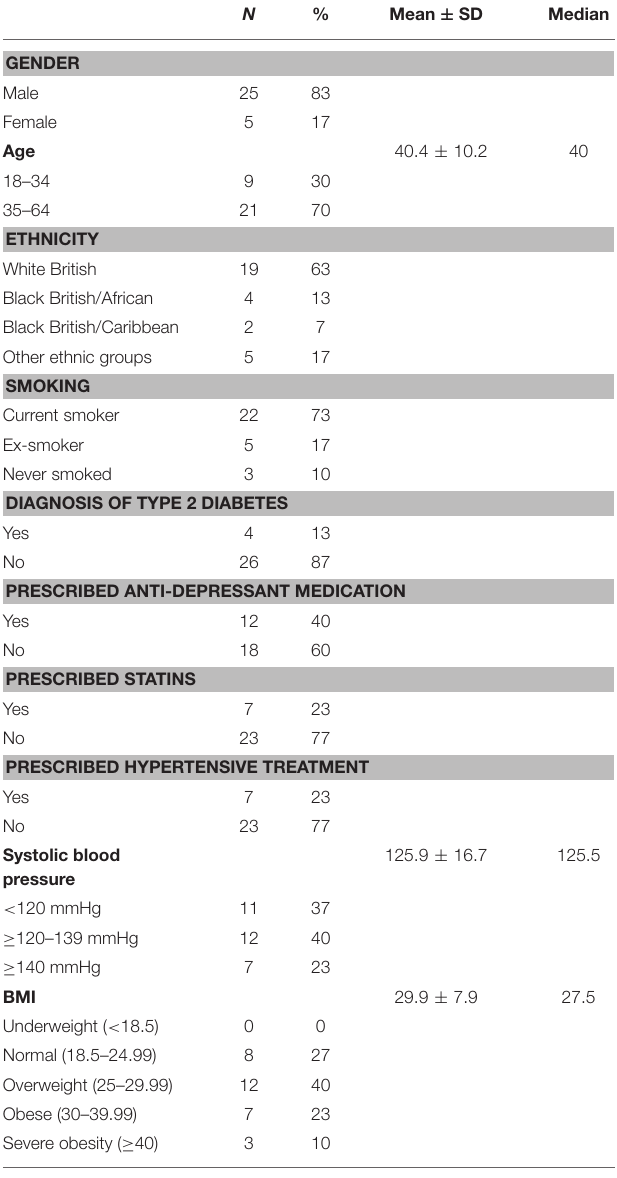
TABLE 2 | Distribution of sociodemographic and clinical factors in the sample of patients diagnosed with